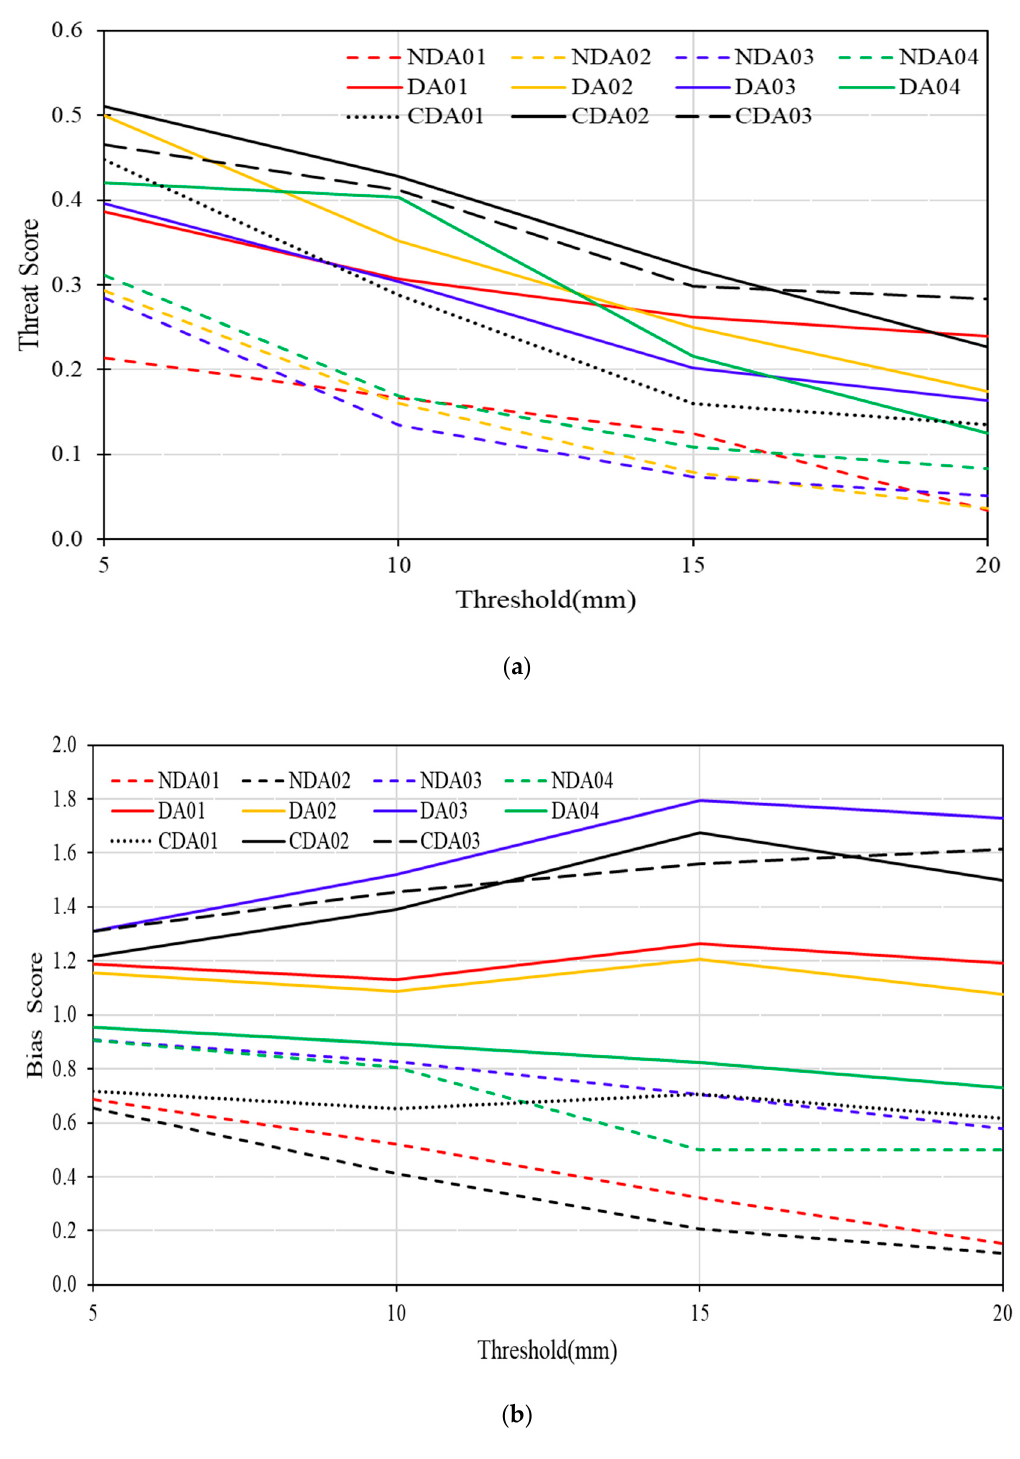
Figure 14. ( a )Threat Score (TS) and ( b ) Bias Score (BS) of C1, C2 and C3 experiments for the 6-h accumulated precipitation (mm) against the corresponding AWS observations during 0500–1100 UTC (1300–1900 LST). Verification thresholds are 5, 10, 15, and 20 mm. For the C1 and C2 group experiments, TS and BS tended to be higher at the thresh- olds of 5 and 10 mm than at 15 and 20 mm. Higher thresholds with lower scores might be for the 6-h accumulated precipitation. For the thresholds of 5, 10, 15, and 20 mm, the sta-